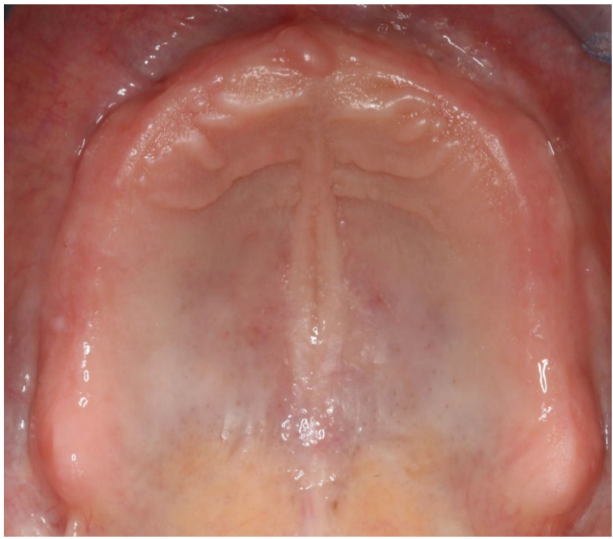
Figure 2. Intraoral photograph of the edentulous upper jaw.